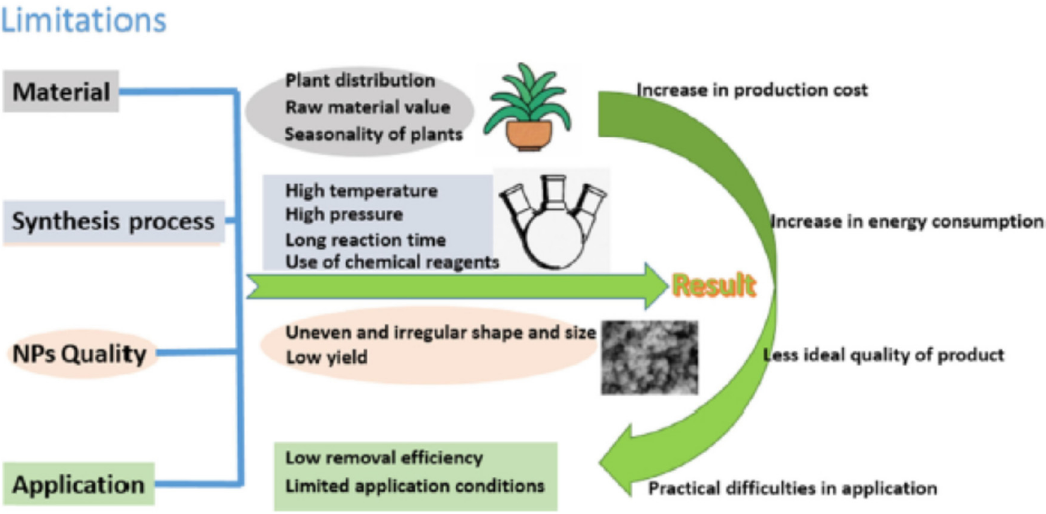
Figure 16: The problems and limitations of green synthesis technology that must be considered in future research [ 81 ] . Copyright © 2022;